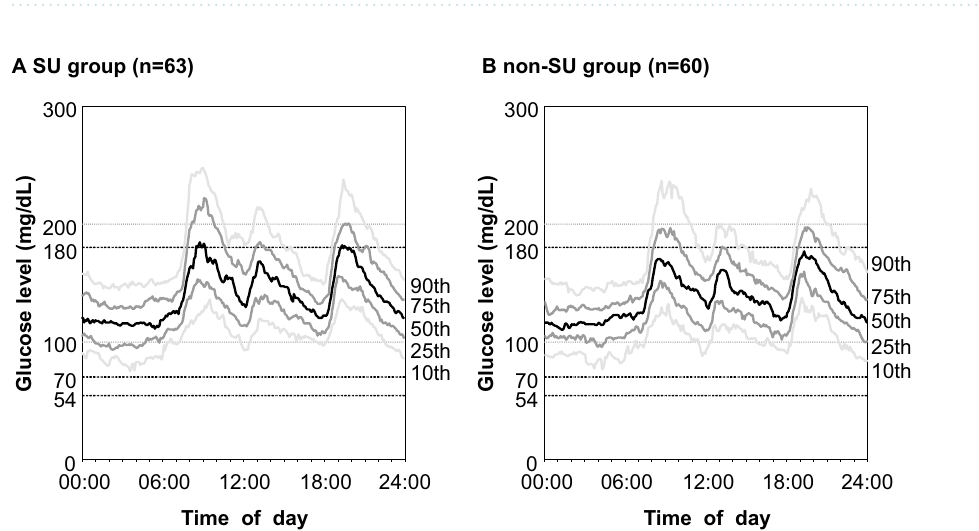
Table 2. CGMS parameters of study participants. Data are mean ± SD. P values are for the differences between the SU and non-SU groups. *p < 0.05 by Mann–Whitney’s U test.